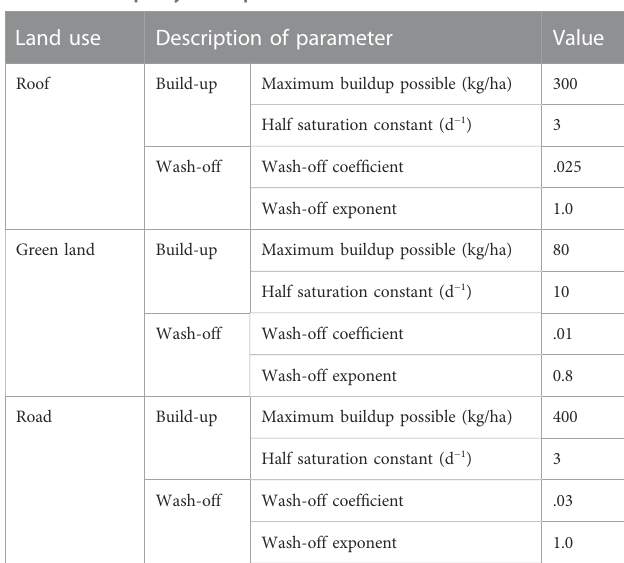
TABLE 1 Water quality model parameter value.